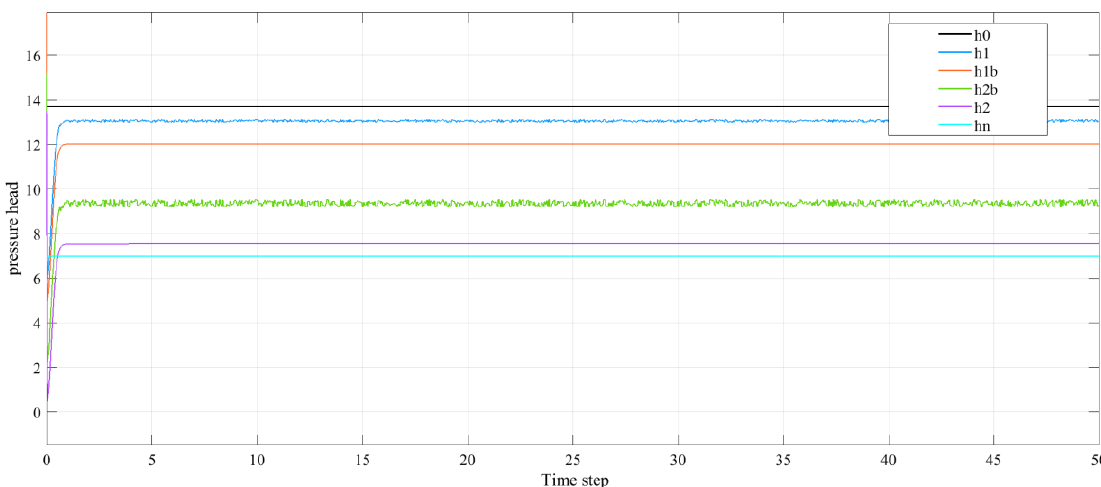
Figure 5. Pressure head in pipeline.